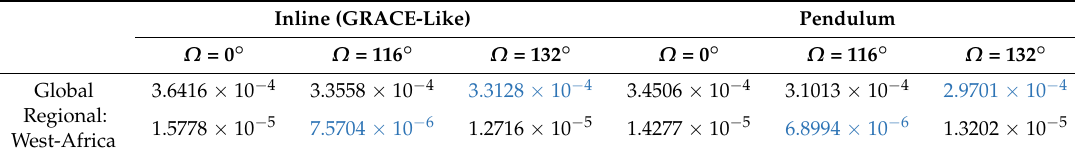
Table 8. Error RMS in terms of geoid height for global and regional (West-Africa) 6-day recovery up to L max = CNR of the scenario (b) inline and Pendulum formations. The smallest values in global and regional cases for each inline and Pendulum formation are written in blue.